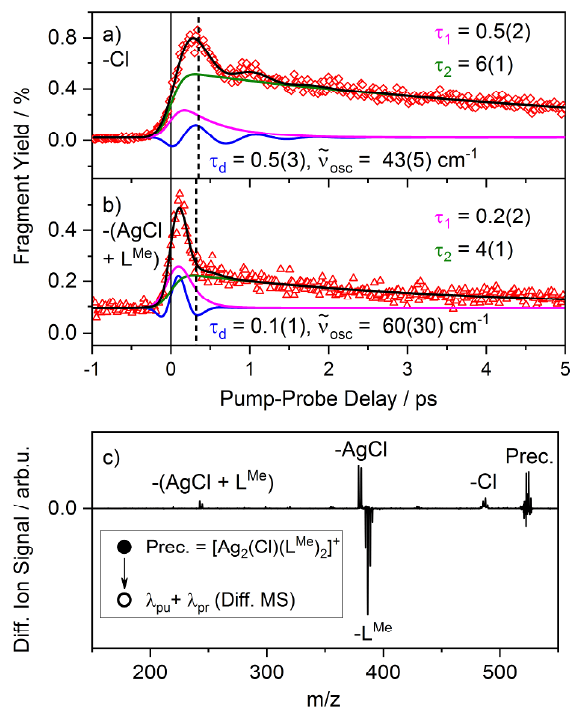
Fig. 2. Fragment-specific transients of [Ag 2 (Cl)(L Me ) 2 ] + (λ pump : 280 nm / λ probe : 1150 nm) corresponding to a) loss of Cl atom and b) loss of AgCl + L Me , respectively. Kinetic fits (black lines) and individual decay contributions associated with time constants τ 1 (magenta), τ 2 (green), oscillatory components with coherence decay times τ d (blue) and oscillation frequencies ν osc are displayed. The fit function corresponds to a convolution of a Gaussian (FWHM ~ 300 fs) with a sum of a biexponential decay function and a damped sine function. c) Difference mass spectrum (Diff. MS) obtained by subtracting the mass spectrum at negative pump-probe delay (~ -(1-0.3) ps) from the spectrum at positive delay (~ 0.2-0.6 ps). Positive and negative Diff. MS signals correspond to an enhancement and depletion, respectively. Fragment mass peaks are labelled according to their neutral losses relative to the intact precursor ion